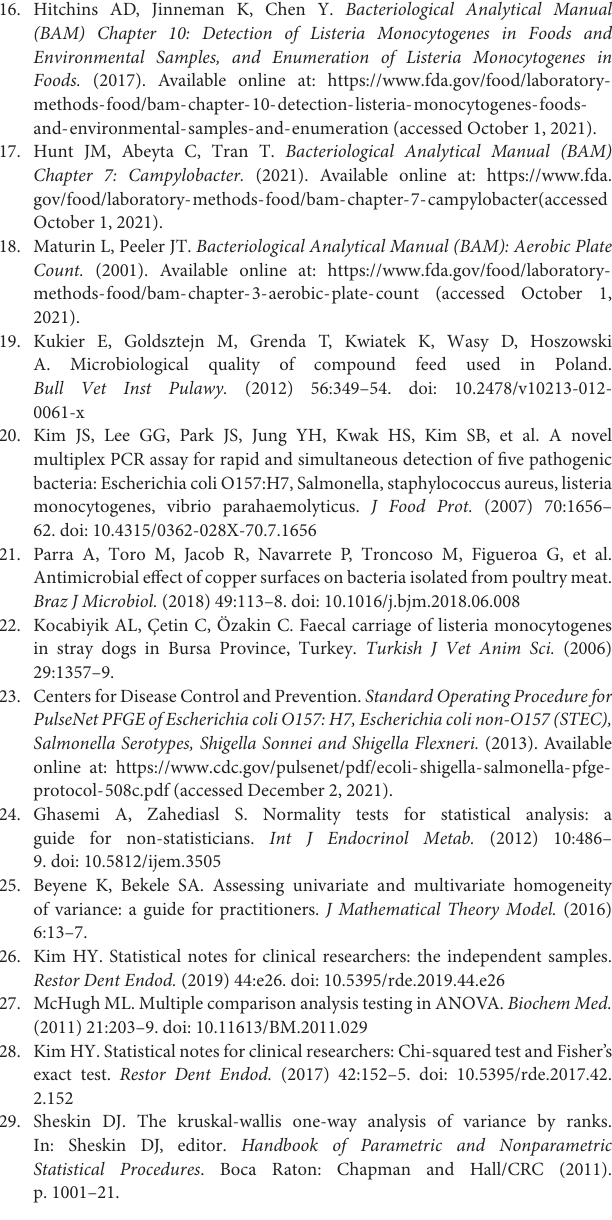
Supplementary Table 1 | Demographics of dogs enrolled in the study ( n = 55). Supplementary Table 2 | Characterization of the RMBDs analyzed (n = 42). Supplementary Table 3 | Demographics of dog owners (n = 36). Supplementary Table 4 | RMBD-fed dog owners’ perceptions about risks and benefits related to RMBDs. Supplementary Table 5 | RMBD-fed dog owners’ main characteristics and